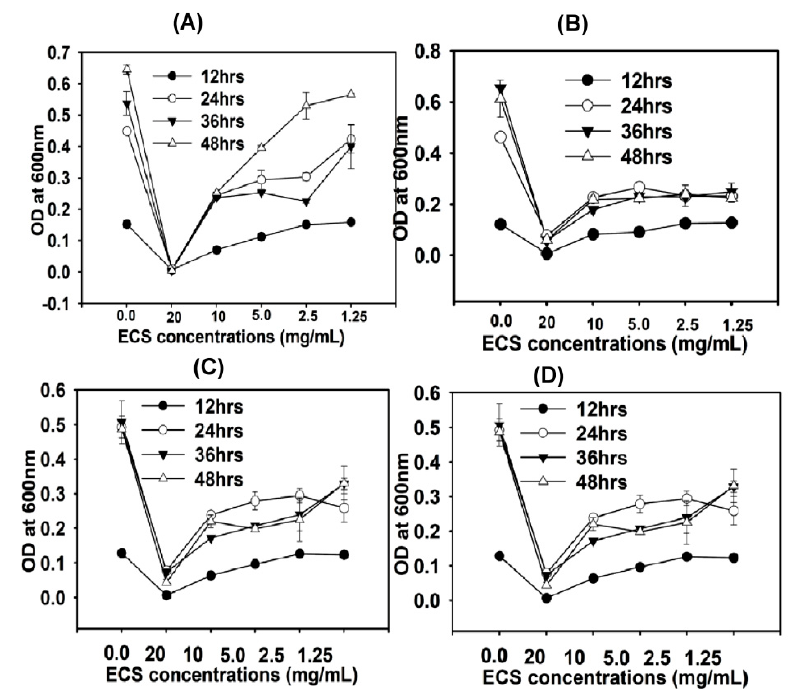
Figure 4 Antibacterial effects of ECS of TC50 on pathogenic bacteria as measured by time killing assay method. ECS of TC48 at different concentrations ranges from 20–1.25 mg/mL on E. coli ( A ), E. faecalis ( B ), P. aeruginosa ( C ) and S. aureus ( D ). Data represent the mean ± STD, ( n = 5).